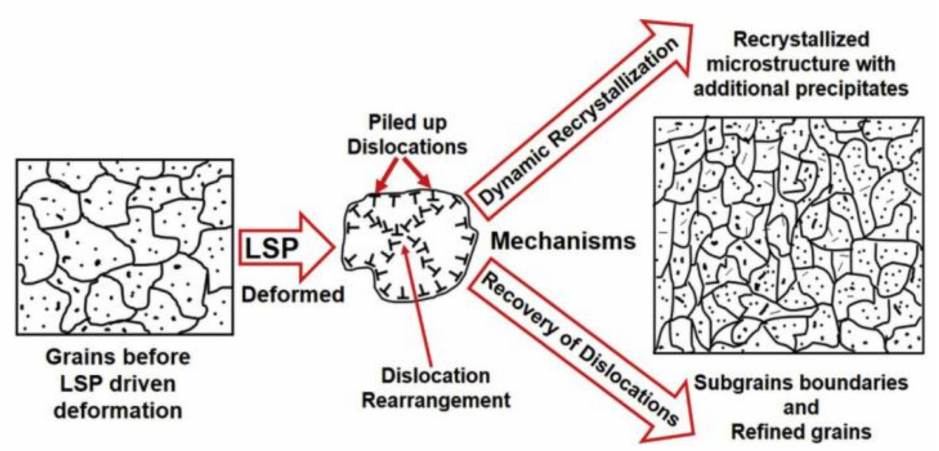
Figure 21. Schematic diagram of microstructure evolution during age-hardening aluminum alloy laser shot peening